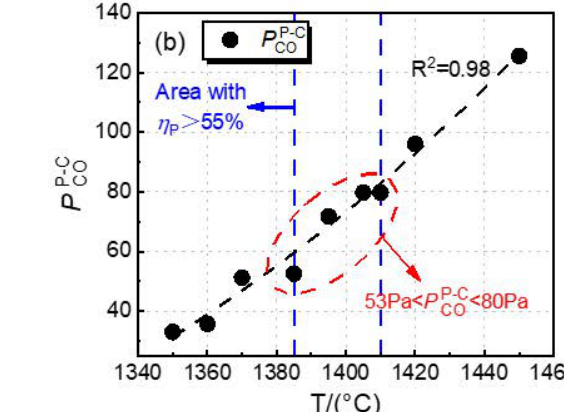
Figure 8. ( a ) Comparison between the predicted value based on multiple regression and the calculated value of a FeO from the regular solution model; ( b ) Effect of dephosphorization endpoint temperature on P P − C carbon and